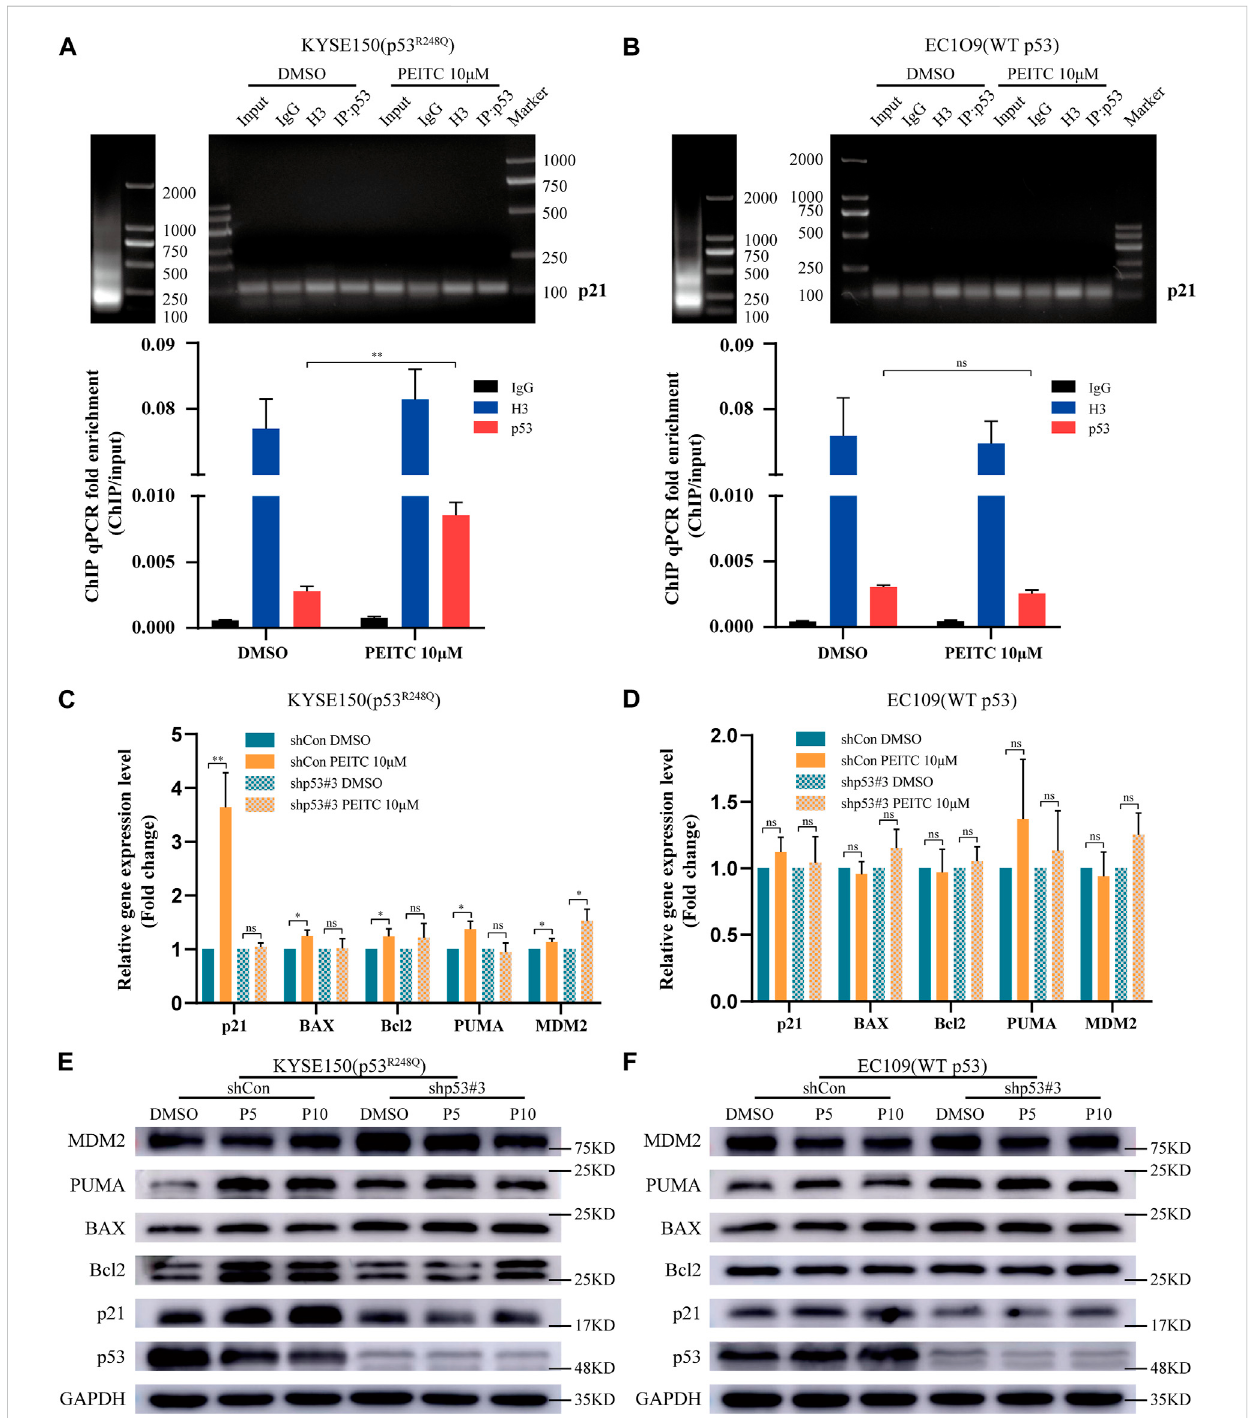
FIGURE 3 PEITC restores the DNA binding ability of the p53 R248Q mutant, and the restoration of the transactivational functions by PEITC is p53 mutant- dependent. (A,B) ChIPwasperformedtoverifythatPEITCrestoresthebindingofthep53 R248Q mutanttothep21promoter.Left,lanesshowingthesizeof the ultrasonicated product. Right, lanes showing the p21 promoter detected by agarose gel electrophoresis. Below, statistical histogram. Input refers to thewholelysateofcells. (C,D) RT-qPCRofp53-regulatedgenesincellstreatedwithDMSOorPEITCfor24 h (E,F) Theexpressionlevelsofp53,p21, Bcl2, BAX, PUMA, MDM2 and GAPDH proteins were measured by Western blot analysis. * p < 0.05; ** p < 0.01. P5, PEITC 5 μ M; P10, PEITC 10 μ M. The cell experiment was repeated three